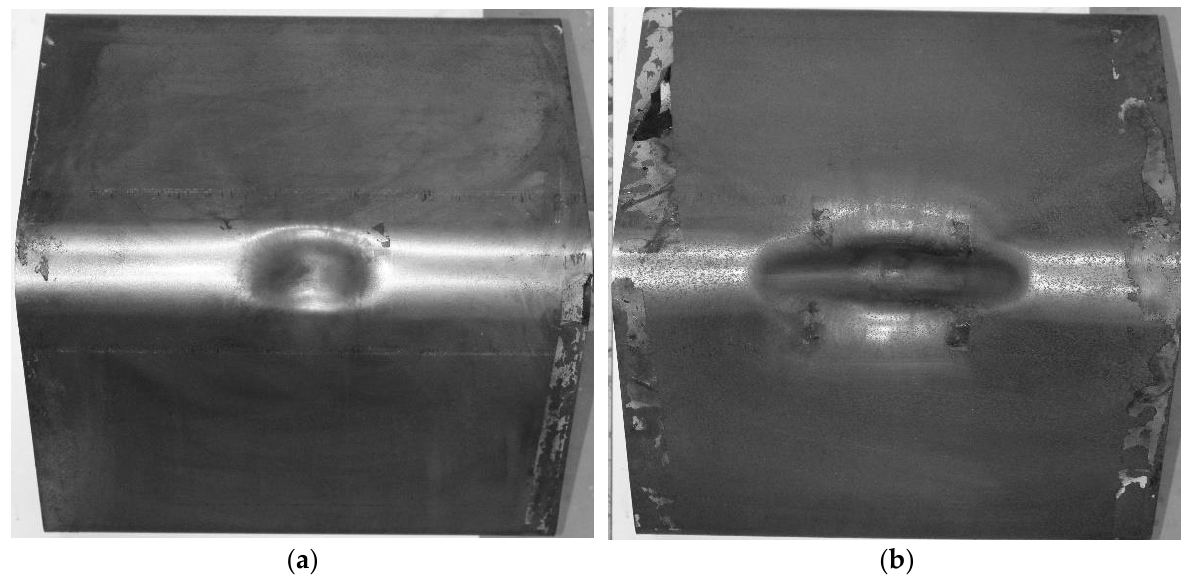
Figure 6. Photographs showing the top view a blast-tested 105° V-structure, 32 mm tip radius, with localised permanent deformation along the central ridge: ( a ) tested at 10 g, ( b ) tested at 40 g.